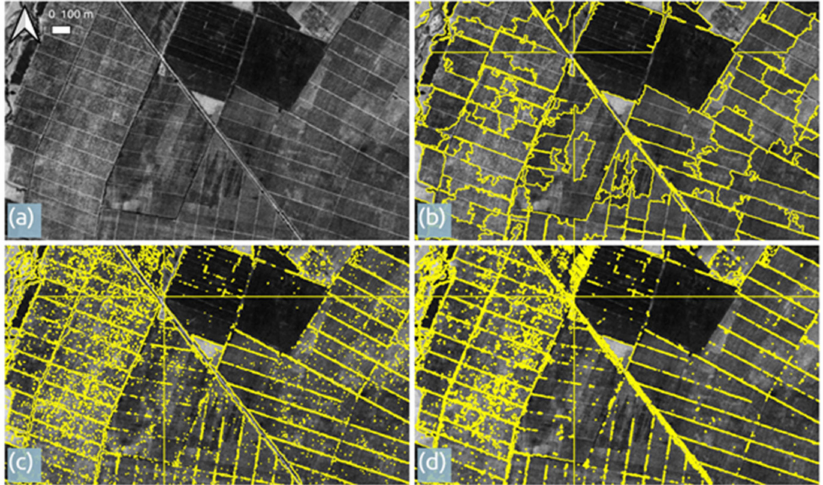
Figure 5. A typical agricultural area in Plovdiv as depicted in the Corona post-processed image ( a ) and best examples of segmentation corresponding to agricultural fields from the mean-shift ( b ), connected components ( c ) and watershed ( d